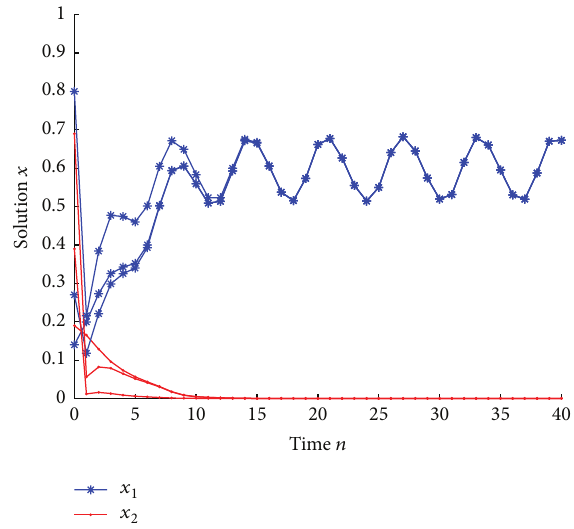
Figure 1: Dynamic behaviors of system (3) with initial values (0),𝑥 (0)) = (0.14, 0.19) , (0.27, 0.69) , and (0.8, 0.39) , respec- (𝑥 1 2